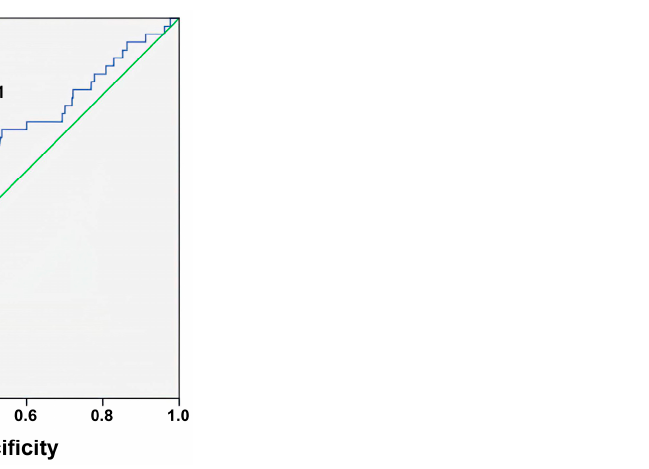
Figure 2. Identification of the cut-off values for predicting mortality based on the De Ritis ratio using the receiver operating characteristic curve analysis. Blue line is the plotted line of the De Ritis ratio; Green line indicates the reference line when AUC is equal to 0.5.